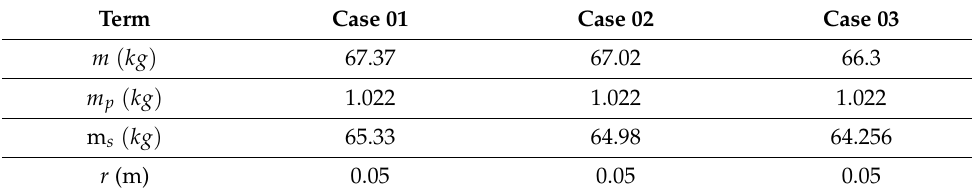
Table 2. Values of the